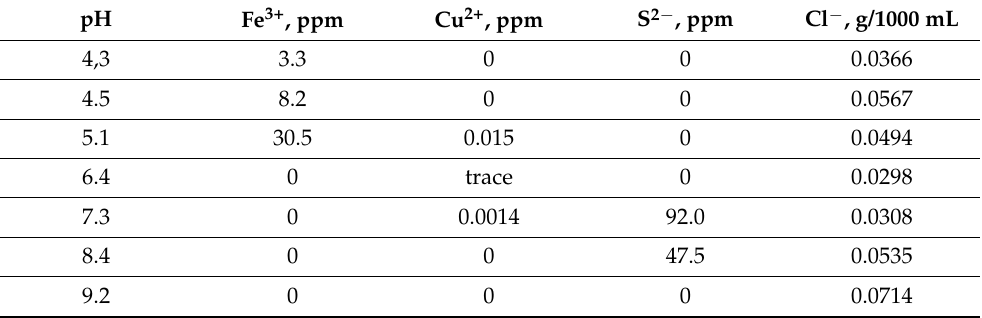
Table 2. The results obtained from the analysis of the products at the top of the distillation column.